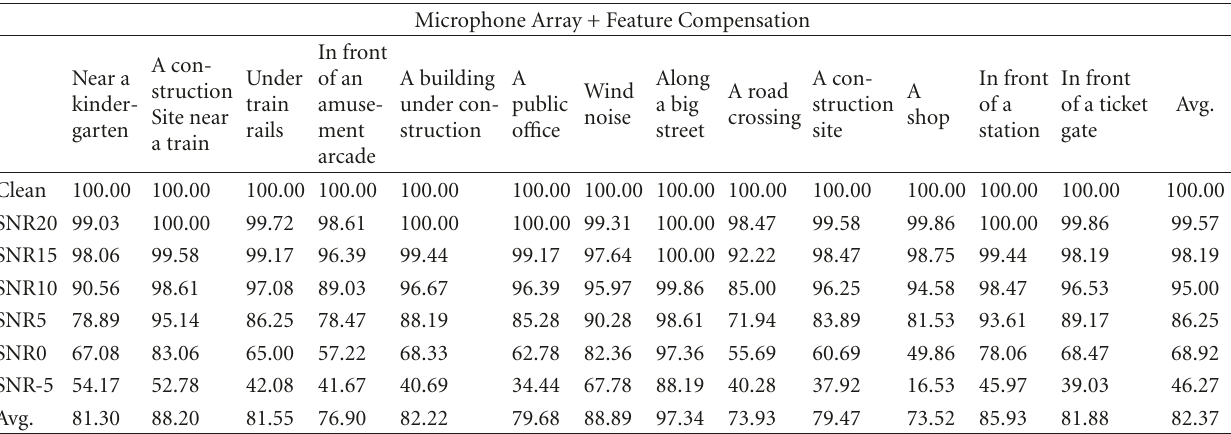
Table 4: Recognition accuracy of the microphone array followed by feature